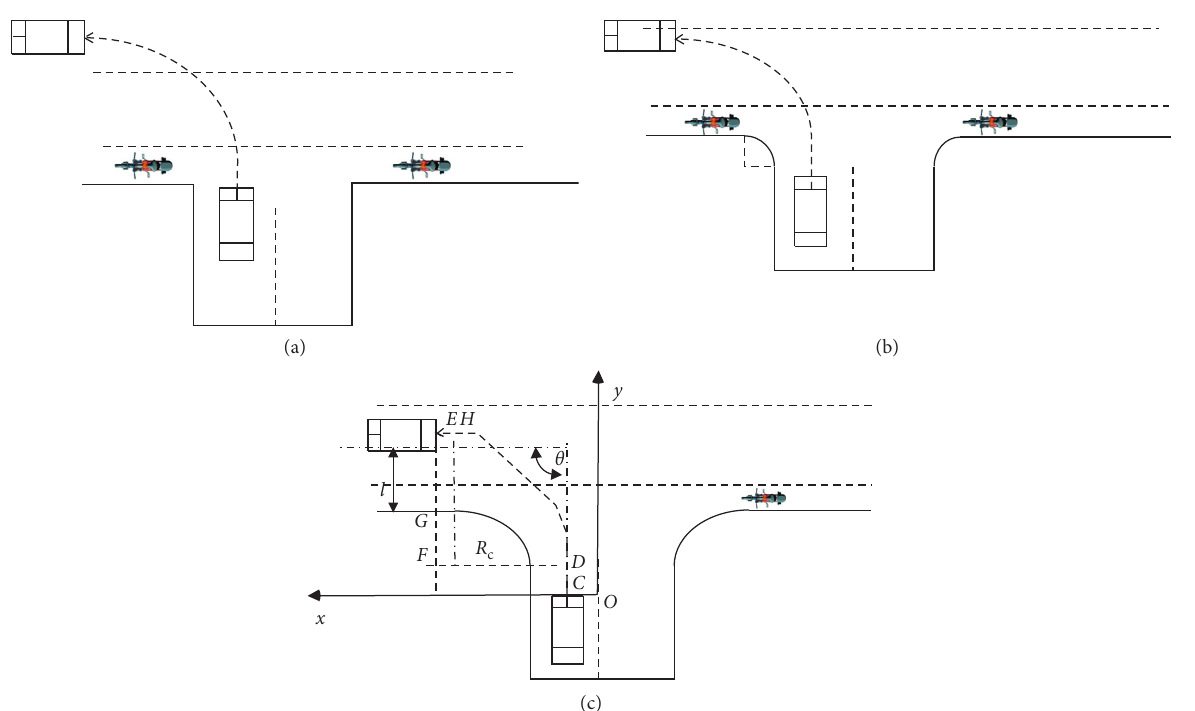
Figure 14: Left turns on the driveway. (a) Driveway without exiting radius. (b) Driveway with small exiting radius. (c) Driveway with large exiting